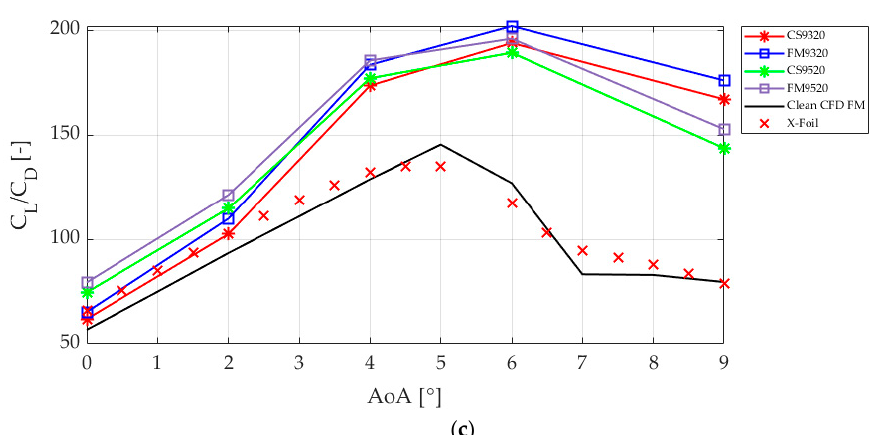
Figure 4. Aerodynamic performance curves (C L /C D , lift-to-drag ratio) for different positions on the pressure side of a DU91W(2)250 airfoil: x = 93% of c and x = 95% of c. Each plot has one MT length (y) assigned: ( a ) y = 1.0% of c; ( b ) y = 1.5% of c; ( c ) y = 2.0% of c. Angles of attack (AoAs) range between 0 and 9°.